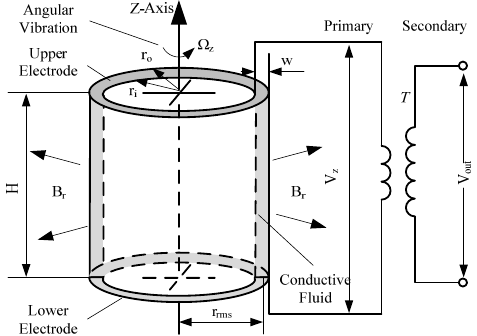
Figure 1. Working principle of the MHD sensor.